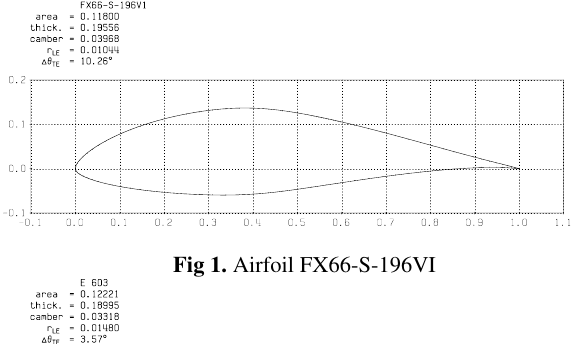
Fig 1. Airfoil FX66-S-196VI